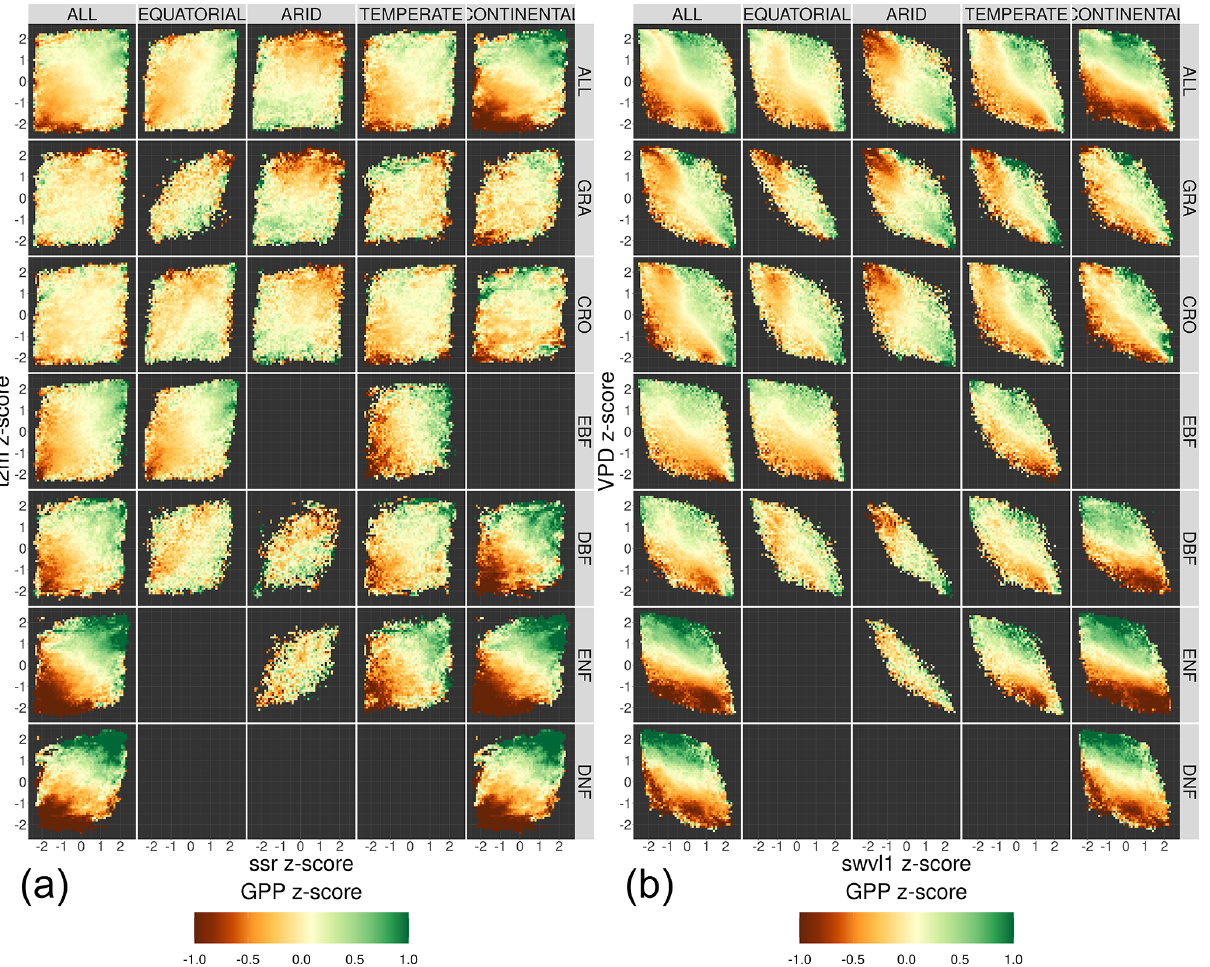
Figure A1. The relationship between fluctuations in meteorological variables and the corresponding fluctuations in the FLUXCOM GPP. The fluctuations are measured relative to the monthly mean for each pixel and expressed as a z score. The four meteorological variables are air temperature and net surface solar radiation (t2m and ssr, a ) and vapour pressure deficit and soil moisture (VPD and swvl1, b ). The GPP FX response in each bin is the mean of all data points in each bin of the meteorological z score. The data are broken down into separate Köppen–Geiger climate zones and land cover categories.